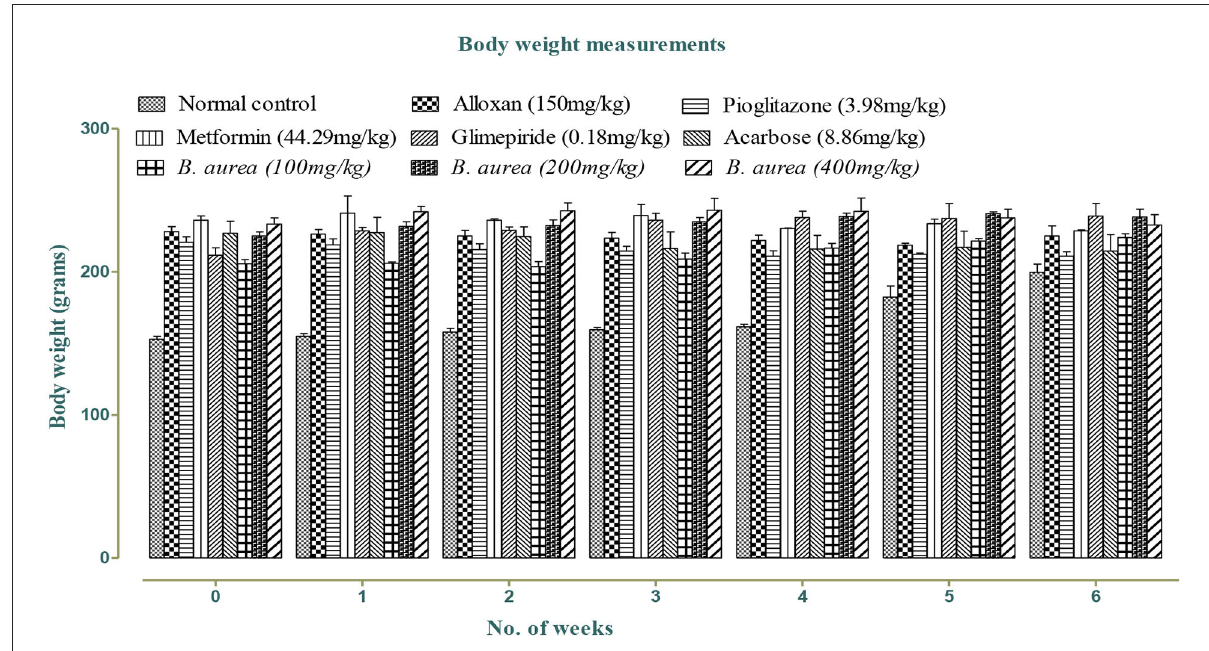
FIGURE1 Effect of different treatments on body weight in alloxan-induced diabetes.